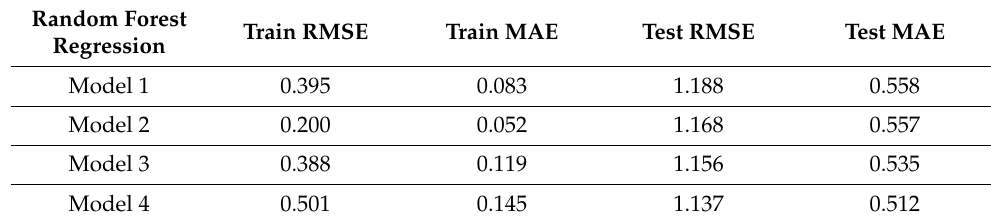
Table 13. Train and test RMSE and MAE for all RFR models.